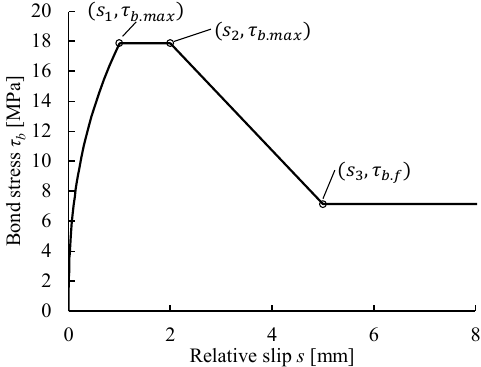
Figure 7. Bond–slip relation between the (longitudinal) steel reinforcement and the concrete in good bond condition according to Model Code 2010 [15].